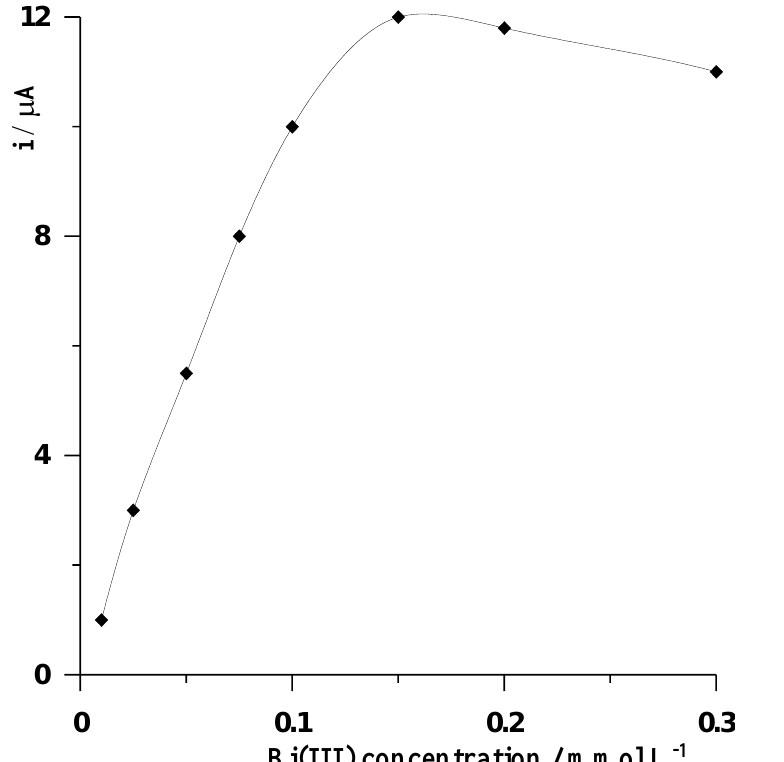
Figure 3. The influence of Bi(III) concentration on the voltammetric signal of 5 × 10 −8 mol L −1 Cd(II). Supporting electrolyte is 0.1 mol L –1 acetate buffer at pH = 3 ± 0.1.